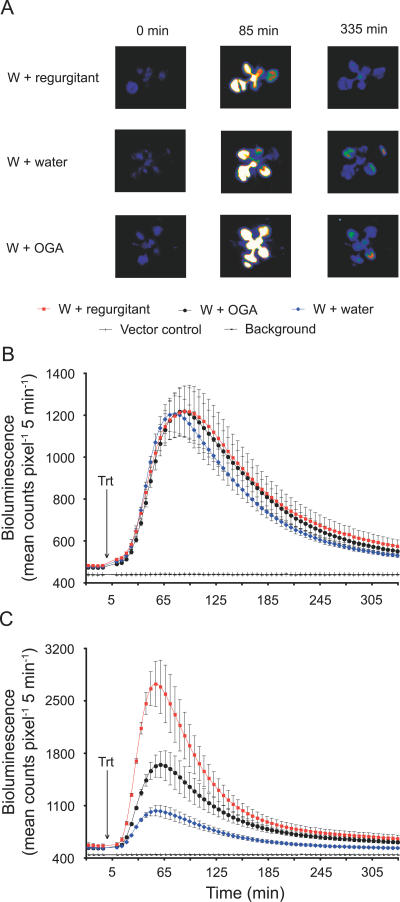
The RSRE Responds to Biotic Elicitors(A) Image of an individual 4xRSRE:LUC transgenic plant over time that was wounded and treated with OGA, IR, or H2O.(B) Local expression in the treated leaves of 4xRSRE:LUC transgenic plants.(C) Systemic expression of 4xRSRE:LUC in the shoot apex. Data are means of 12 ± SEM.